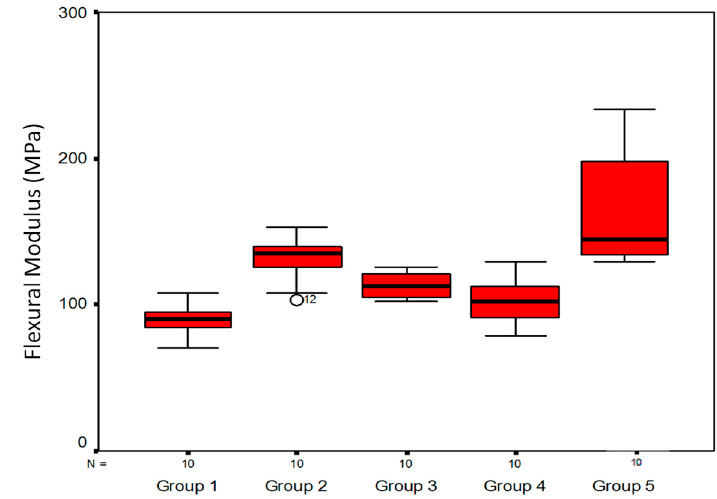
Figure 4. Inter-group distribution of flexural strength (Box–Whisker Plot).